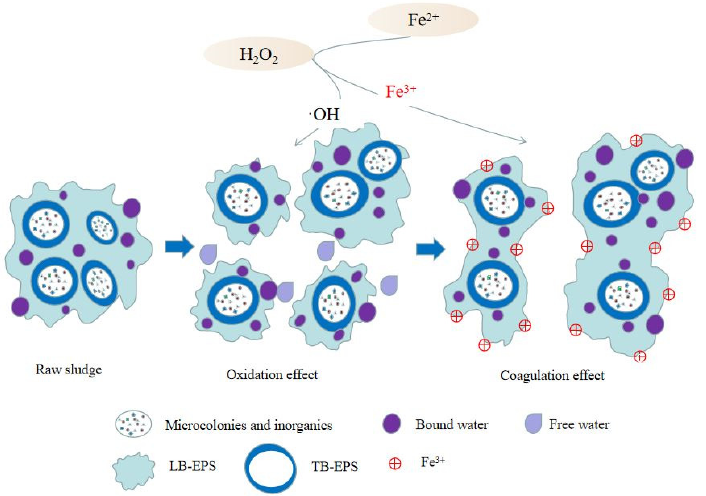
Figure 1. Mechanism of Enhanced Sludge Dewatering by Hydrogen Peroxide Pretreatment. H 2 SO 4 was used to adjust the pH of the sludge. Under the optimal dosage of Fe 2+ and H 2 O 2, the SRF and CST of the sludge were reduced to 6.149 × 10 9 m/kg and 15.7 s, which were 93% and 48.5% lower than the original sludge, respectively, indicating that the sludge dewatering effect is significantly improved [25]. LIU is also in the optimal dose. The sludge specific resistance SRF decreases by 95% below pH = 5, w(Fe 2+ ) = 40 mg/g DS, w(H 2 O 2 ) = 32 mg/g DS, lime = 400 mg/g DS [26]. Fenton’s reagent has been shown to be an